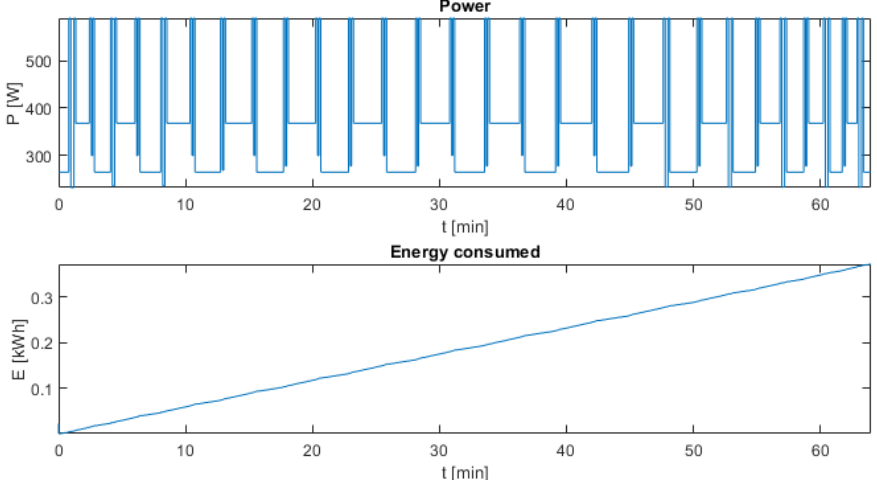
Figure 10. Estimated power and energy consumption during spraying of Jazbina vineyard, based on topological 3D model (Figure